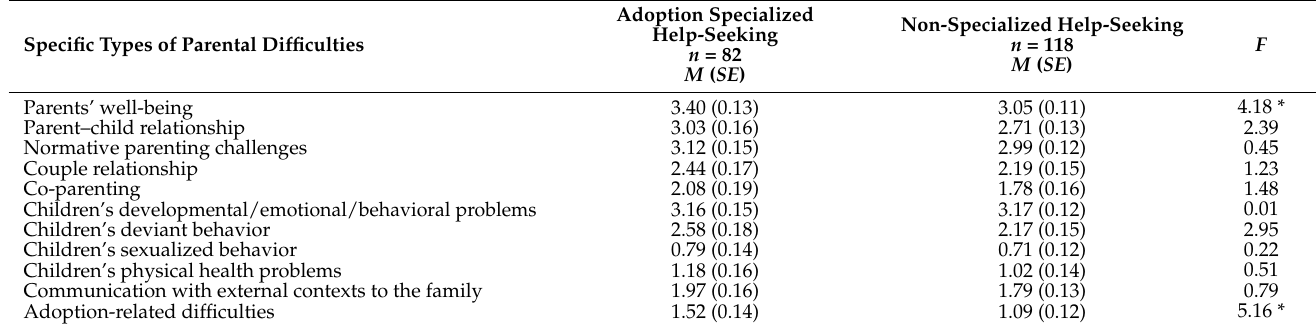
Table 5. Adoptive Parents’ Difficulties by Type of Help-seeking (Adoption-Specialized vs. Non- Specialized Help): Descriptive Statistics and Group